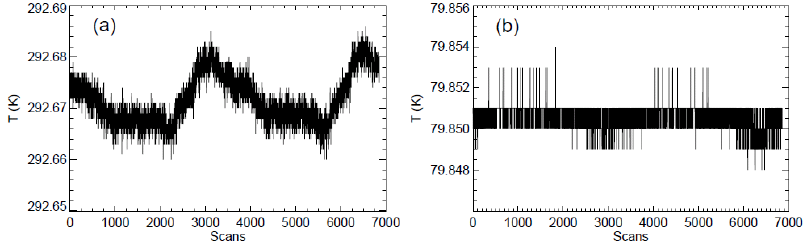
Figure 4. VIIRS BB ( a ) and S/MWIR focal plane assembly (FPA) ( b ) temperature trending over